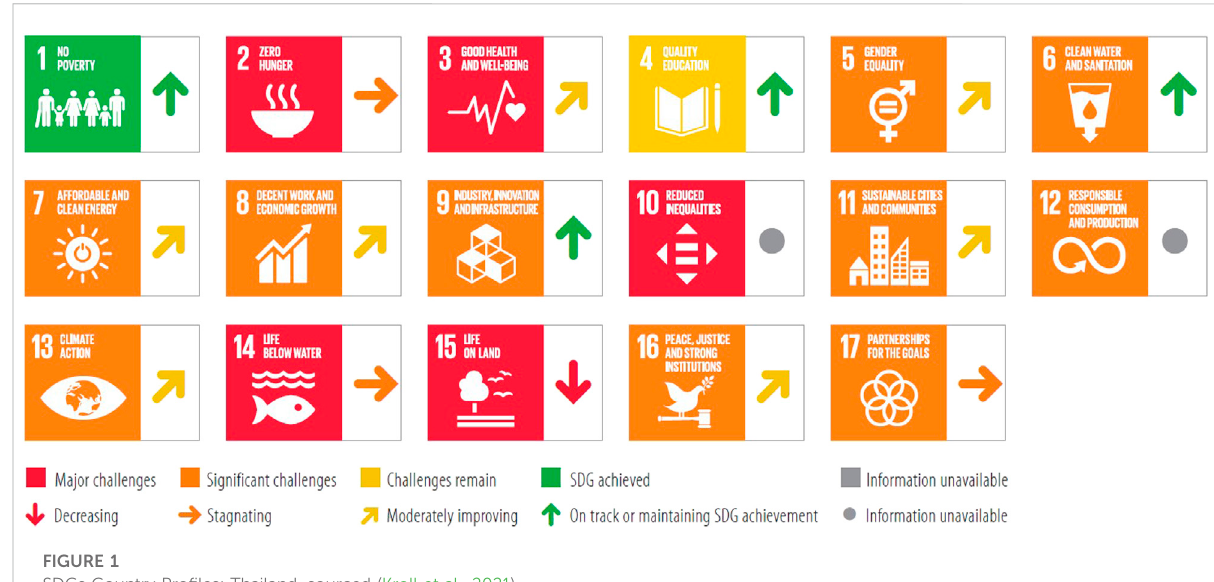
FIGURE 1 SDGs Country Pro fi les; Thailand, sourced (Kroll et al.,